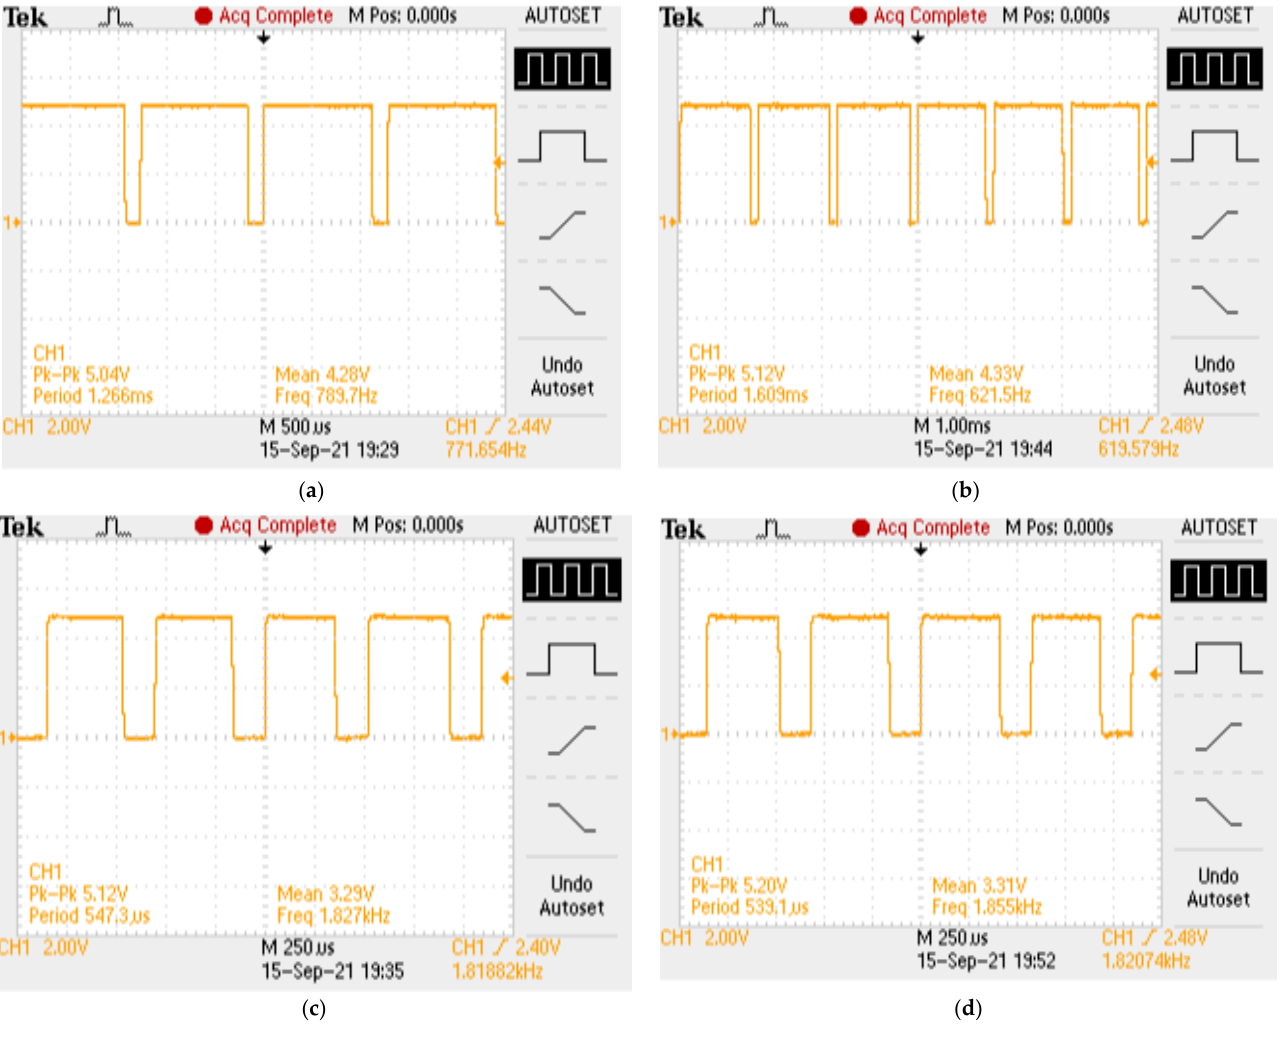
Figure 12. Example results of experiments: ( a ) 20 (rpm), clockwise revolutions; ( b ) 20 (rpm), anti- clockwise revolutions; ( c ) 60 (rpm), clockwise revolutions; ( d ) 60 (rpm), anticlockwise revolutions. Table 2. Comparison of frequency value.